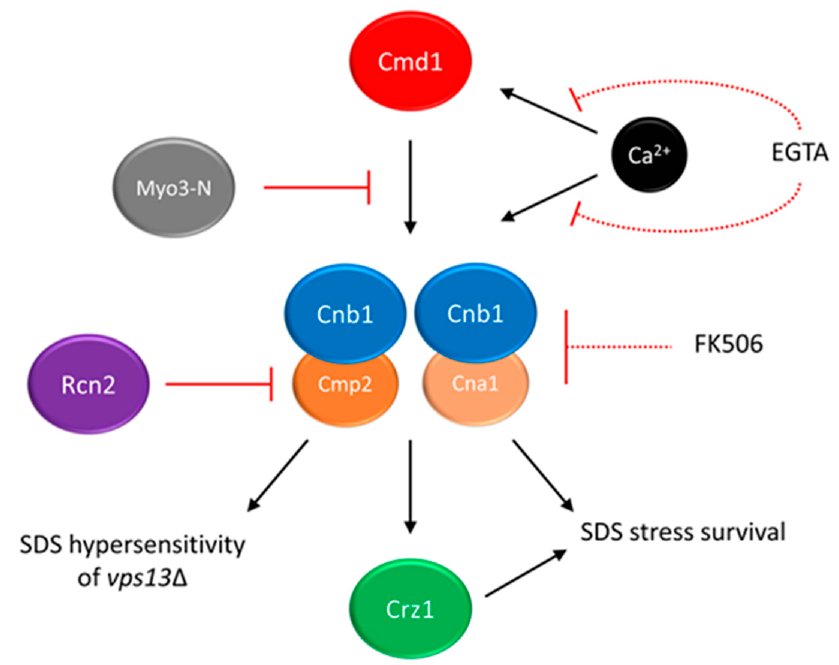
Figure 4. The calmodulin–calcineurin pathway and its impact on yeast growth in the presence of SDS stress. Partial inhibition of calcineurin (Cnb1 + Cna1/Cmp2) activity suppresses the SDS- hypersensitivity of vps13 Δ cells. Multicopy suppressors MYO3-N and RCN2 act by titrating calmodulin or blocking the activity of Cmp2 catalytic subunit, respectively. Chemical suppressors EGTA and FK-506 act by chelating the calcium ions required for calmodulin and calcineurin activities or inhibiting total calcineurin activity, respectively. As full inhibition of calcineurin activity is toxic in the presence of SDS stress, both chemical suppressors must be used in moderate concentration, indicated by dashed lines. Figure is based on results presented in Soczewka et al. 2019 and Wardaszka et al. 2021 [126,136] .